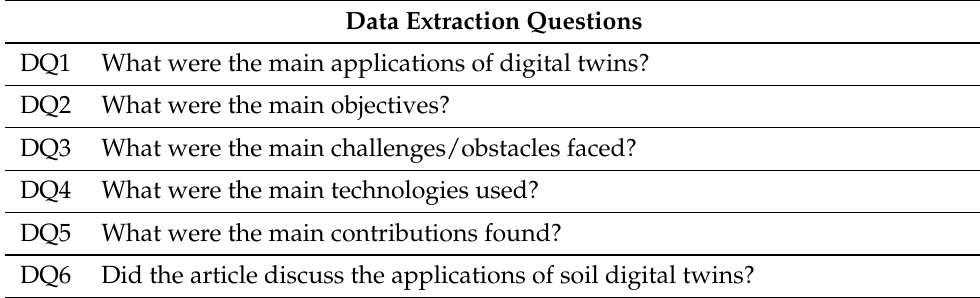
Table 7. Data extraction